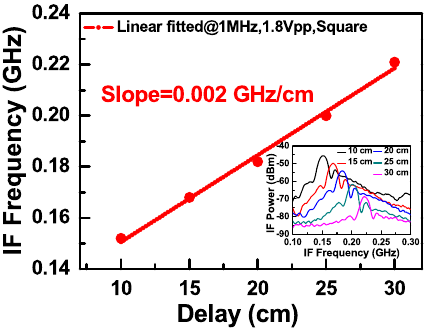
Figure 16. The IF beating frequency versus different delay line distances. Inset picture shows the corresponding IF spectra for different delays.